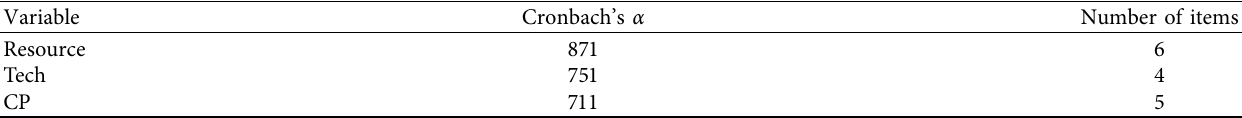
Table 4: Reliability test of the extension model of the enterprise risk management maturity model. Variable Resource